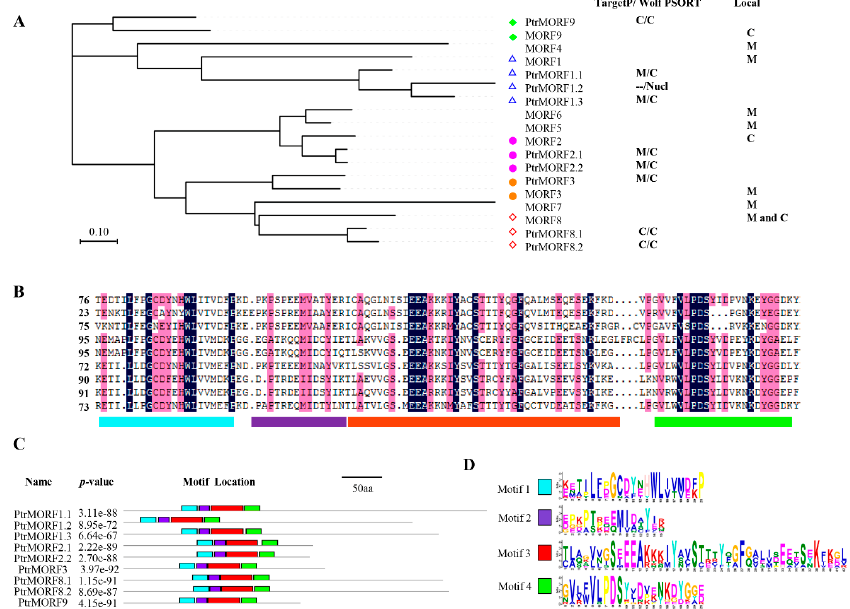
Figure 1. Poplar multiple organellar RNA editing factor (MORF) proteins and their conserved motifs. ( A ) Multiple sequences alignment of A. thaliana and P. trichocarpa MORF proteins was carried out using MUSCLE, and the Neighbor-Joining (NJ) tree was built using MEGA v7.0. And the chloroplast, mitochondrial or nuclei transit peptides of poplar MORF proteins were predicted using TargetP (http://www.cbs.dtu.dk/services/TargetP/) and Wolf PSORT (http://wolfpsort.org/). M, mitochondria; C, chloroplast; Nucl, nuclei. Green diamond, MORF9 and PtrMORF9; Blue triangle, MORF1, PtrMORF1.1, PtrMORF1.2 and PtrMORF1.3; Red circle, MORF2, PtrMORF2.1 and PtrMORF2.2; Orange circle, MORF3 and PtrMORF3; Orange diamond, MORF8, PtrMORF8.1 and PtrMORF8.2. Local meant the gene where was located in ( B ). Alignment of conserved MORF domains in poplar MORF proteins was conducted using DNAMAN (https://www.lynnon.com/). Lake blue, Motif1; purple, Motif2; red, Motif3; green, Motif4. ( C , D ) Putative motifs were explored using the MEME server with the parameters of between 15 and 50 aa in length and sharing of each motif among all PtrMORF